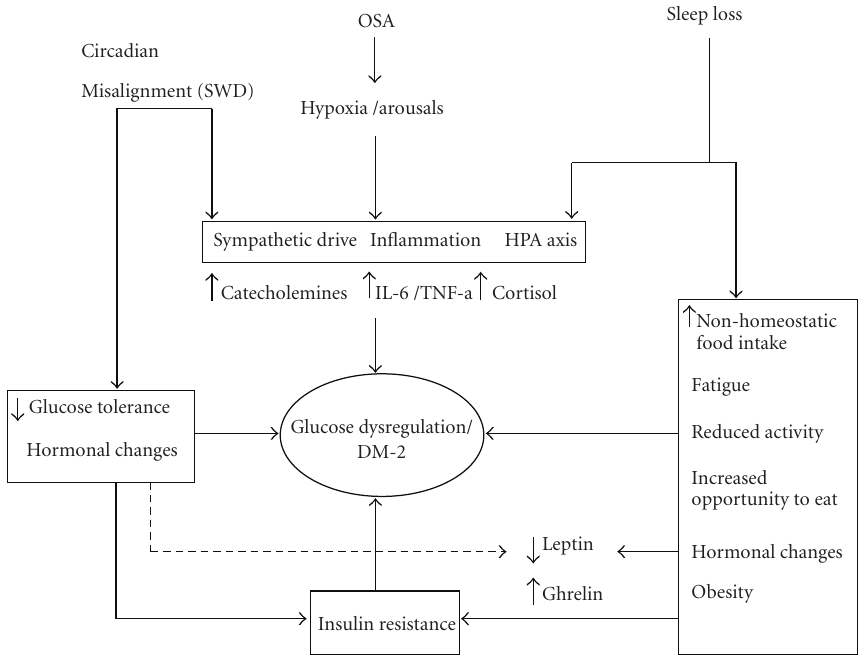
Figure 1: Schematic diagram of potential mechanism of glucose dysregulation/diabetes pathogenesis, secondary to sleep loss, sleep apnea, and circadian misalignment. The three main sleep disorders are listed at the top. Arrows point to possible pathophysiological alteration the disorders may induce. Some of the pathways are common to all the disorders and are listed together, that is, sympathetic drive, inflammation, and alteration of HPA axis. Sleep loss may in addition lead to changes like hormonal imbalance and reduced activity (listed on the box to the right of the diagram). Similarly circadian alteration may also cause insulin resistance and hormonal imbalance (shown in the box to the left). All these pathophysiological alterations eventually may lead to type II diabetes which is shown in the center. SWD: Shift work